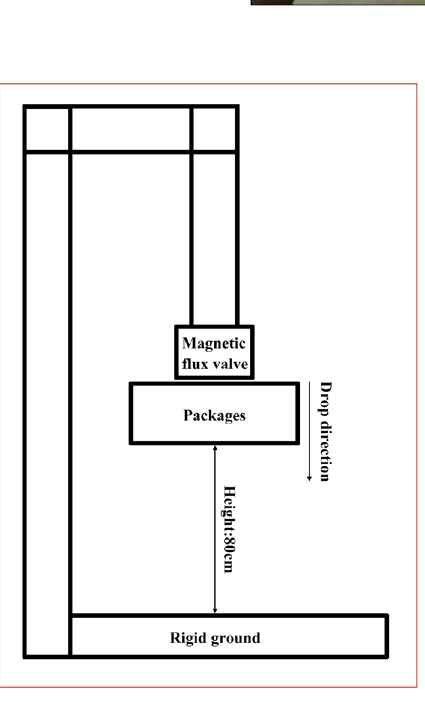
Fig. 15 Schematic diagram of the specific method of falling